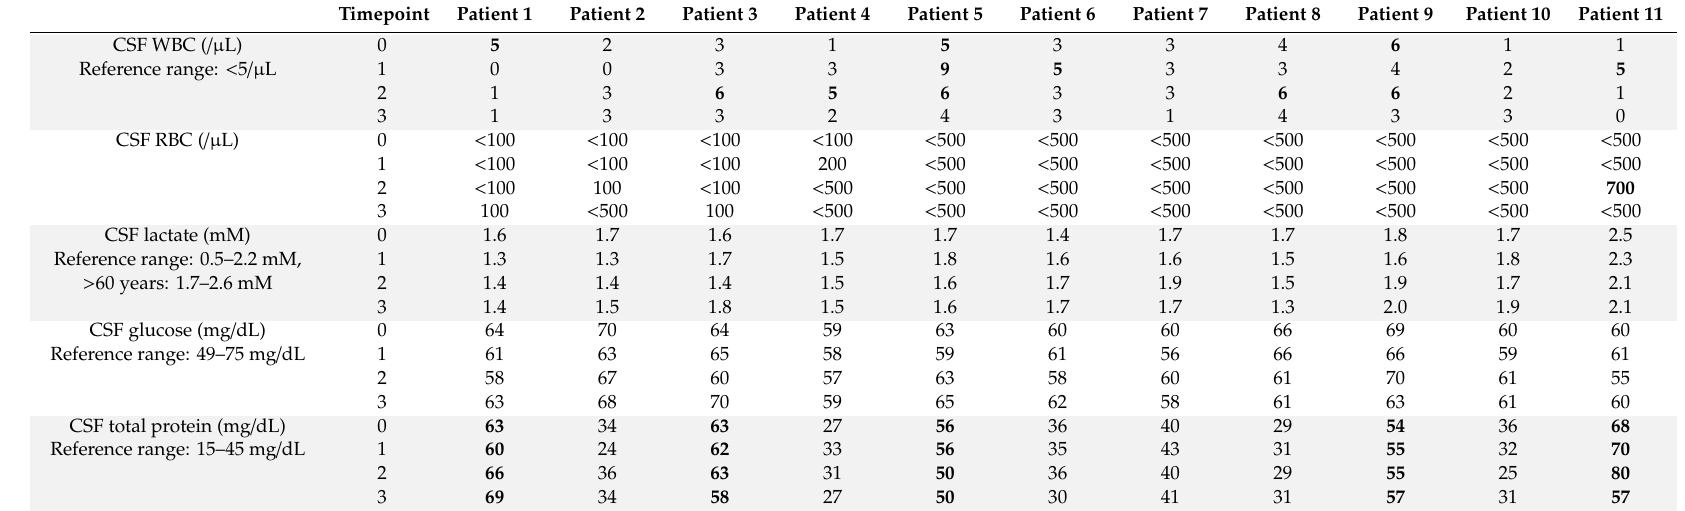
Table 2. White blood cell count (WBC), red blood cell count (RBC), and levels of lactate, glucose, and total protein in Patients 1–11 measured at four timepoints during loading with nusinersen (timepoint 0 = before first administration, timepoint 1 = 14 days after first administration and before second, timepoint 2 = 14 days after second administration and before third, timepoint 3 = 30 days after third administration and before fourth). Levels out of reference range are highlighted in bold. Timepoint Patient 1 Patient 2